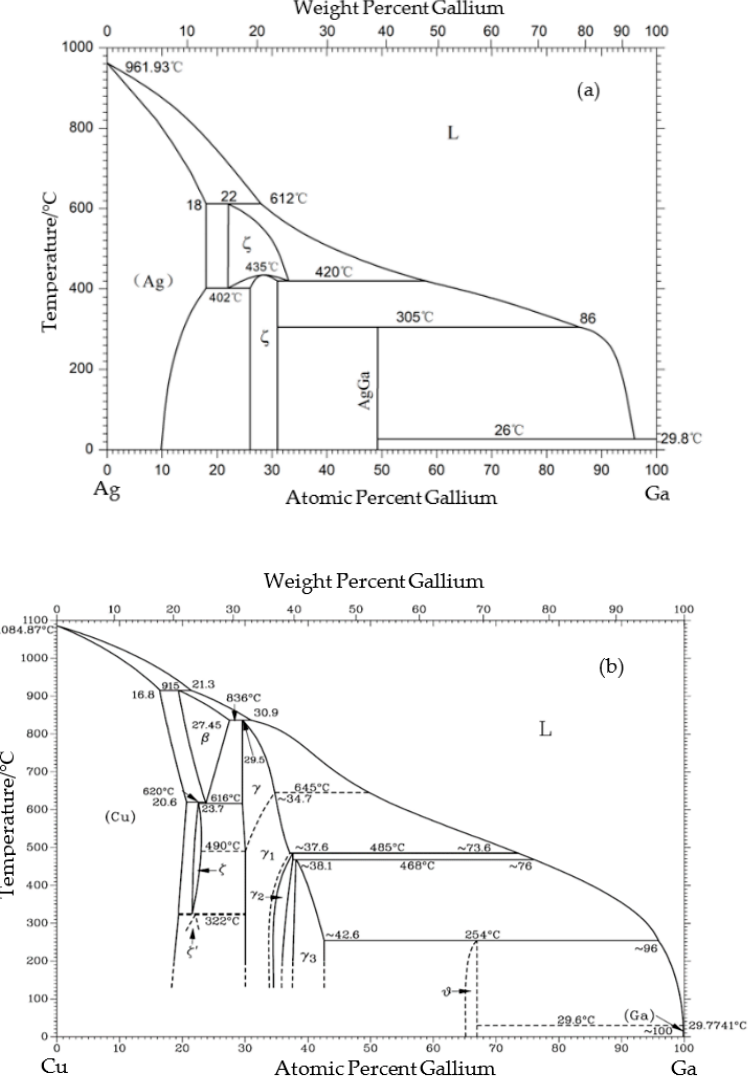
Figure 1. Ag-Ga and Cu-Ga binary phase diagrams: ( a ) Ag-Ga binary phase diagram, ( b ) Cu-Ga binary phase diagram [16].